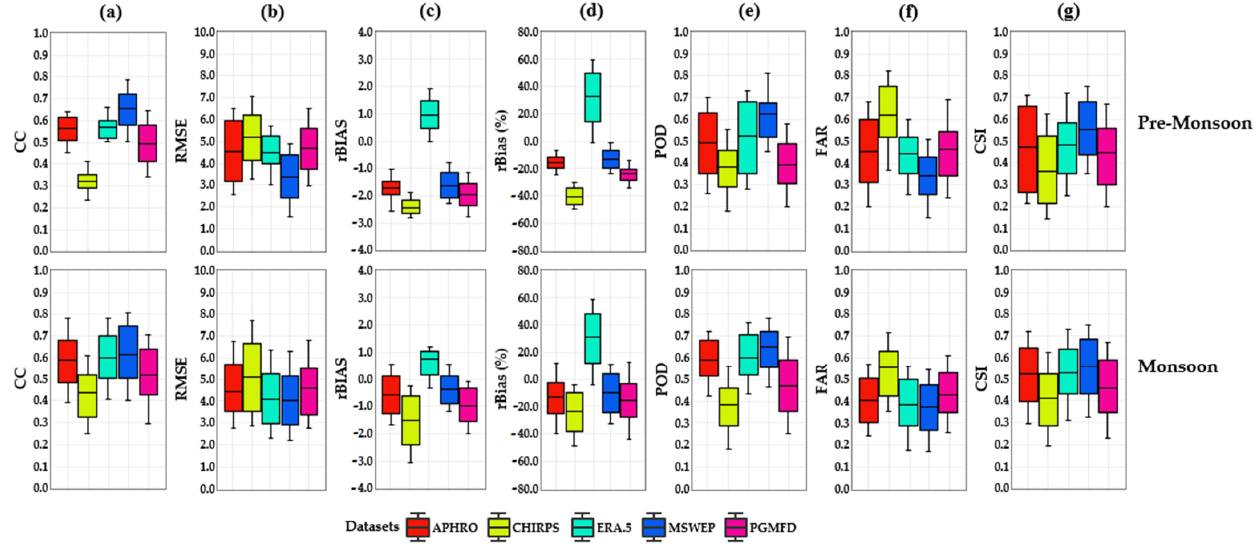
Figure 6. The performance of GPPs at SBs during pre-monsoon and monsoon seasons. The lines of each box from bottom to top represent the minimum, first quartile, median, third quartile, and maximum values, respectively. ( a ) Correlation coefficient, ( b ) Root Mean Square Error, ( c ) relative Bias, ( d ) Relative Bias in percentage, ( e ) Probability of Detection, ( f ) False Alarm Ratio, ( g ) Critical Success Index.